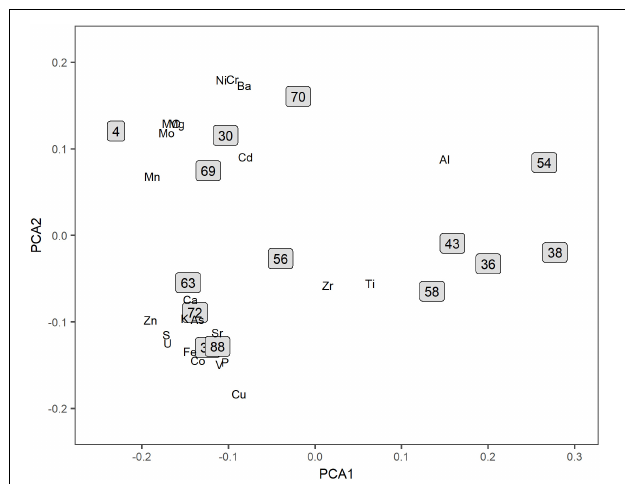
FIGURE 2 | Ordination based on trace-elements. Biplot of the PCA calculated for the concentration of trace-elements and all sampling stations.